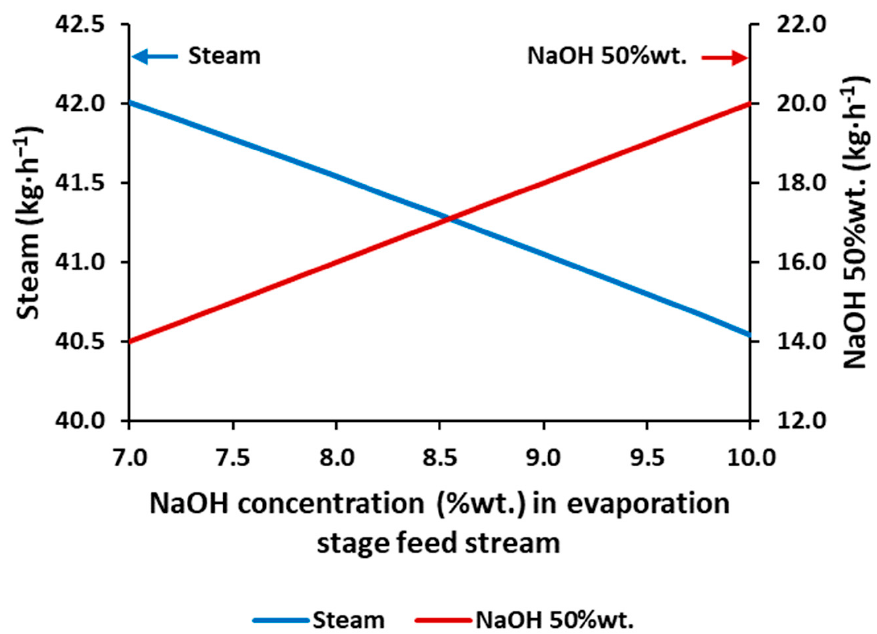
Figure 2. Industrial steam consumption and NaOH 50%wt. flowrate production versus the NaOH concentration in the feed stream of the simulated triple effect evaporation.